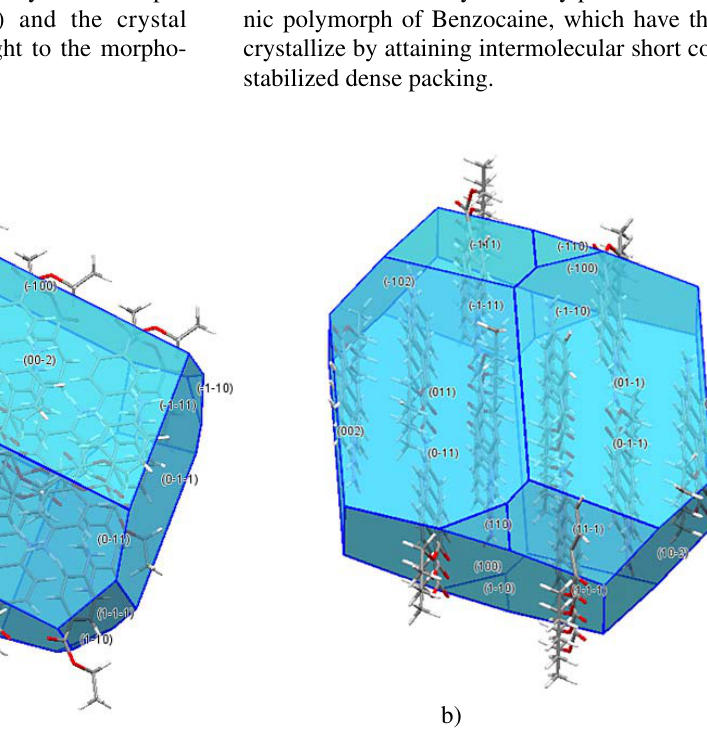
Fig. 16: Predicted morphology of Str 1 with a) longitudinal view b) Transverse view.